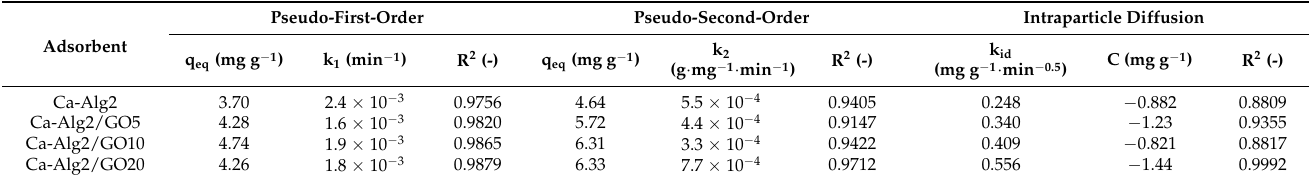
Table 5. Kinetic parameters for FMTD adsorption onto Ca-Alg2, Ca-Alg2/GO5, Ca-Alg2/GO10 and Ca-Alg2/GO20 dried beads. Adsorbent